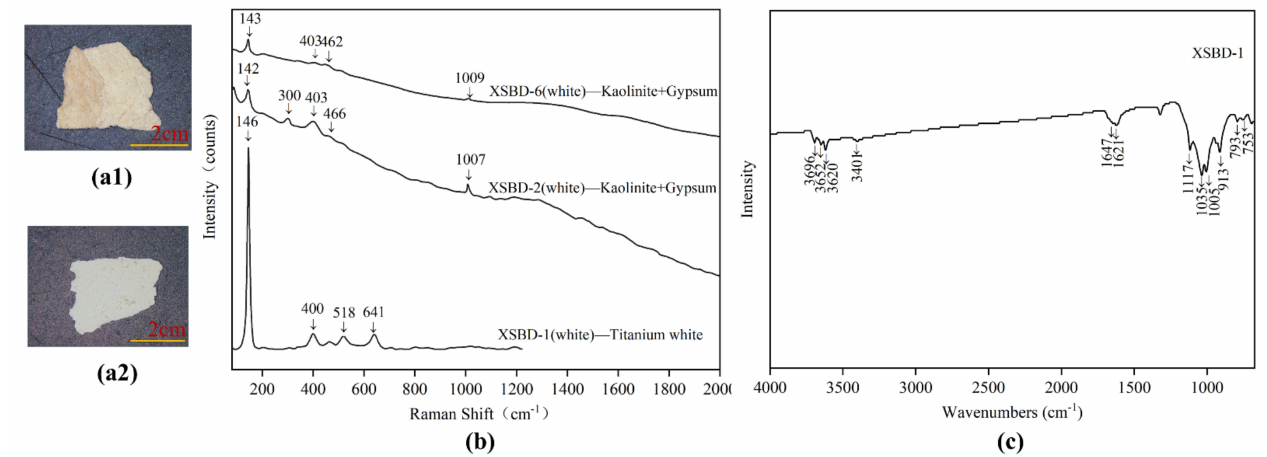
Figure 14. Digital microscopy (DM) of white pigment samples ( a1 ) XSBD-1; ( a2 ) XSBD-6, Micro- Raman spectroscopy; ( b ) XSBD-1; XSBD-2; XSBD-6 and FT-IR spectra; ( c )